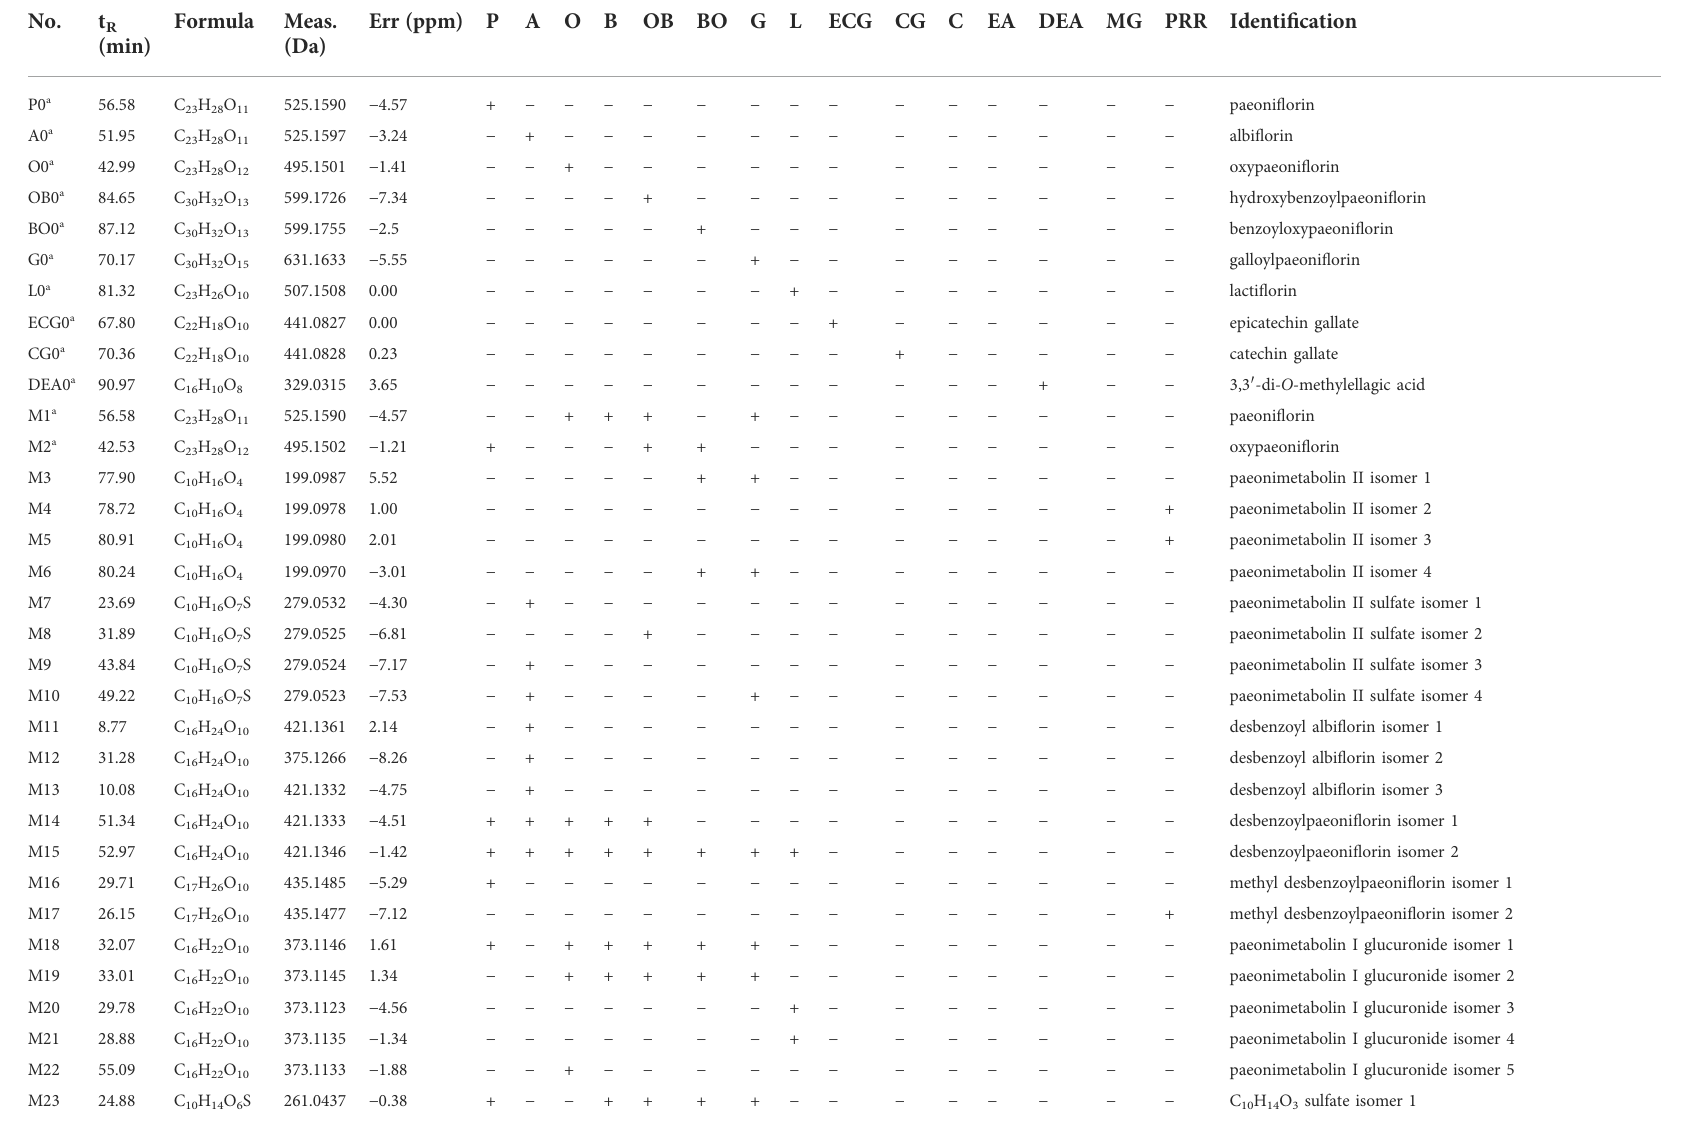
TABLE 1 Retention times (t R ) molecular formulae, and identities of 10 absorbed compounds and 195 metabolites of PRR and its 14 constituents in mice based on HPLC-ESI-IT-TOF-MS n .